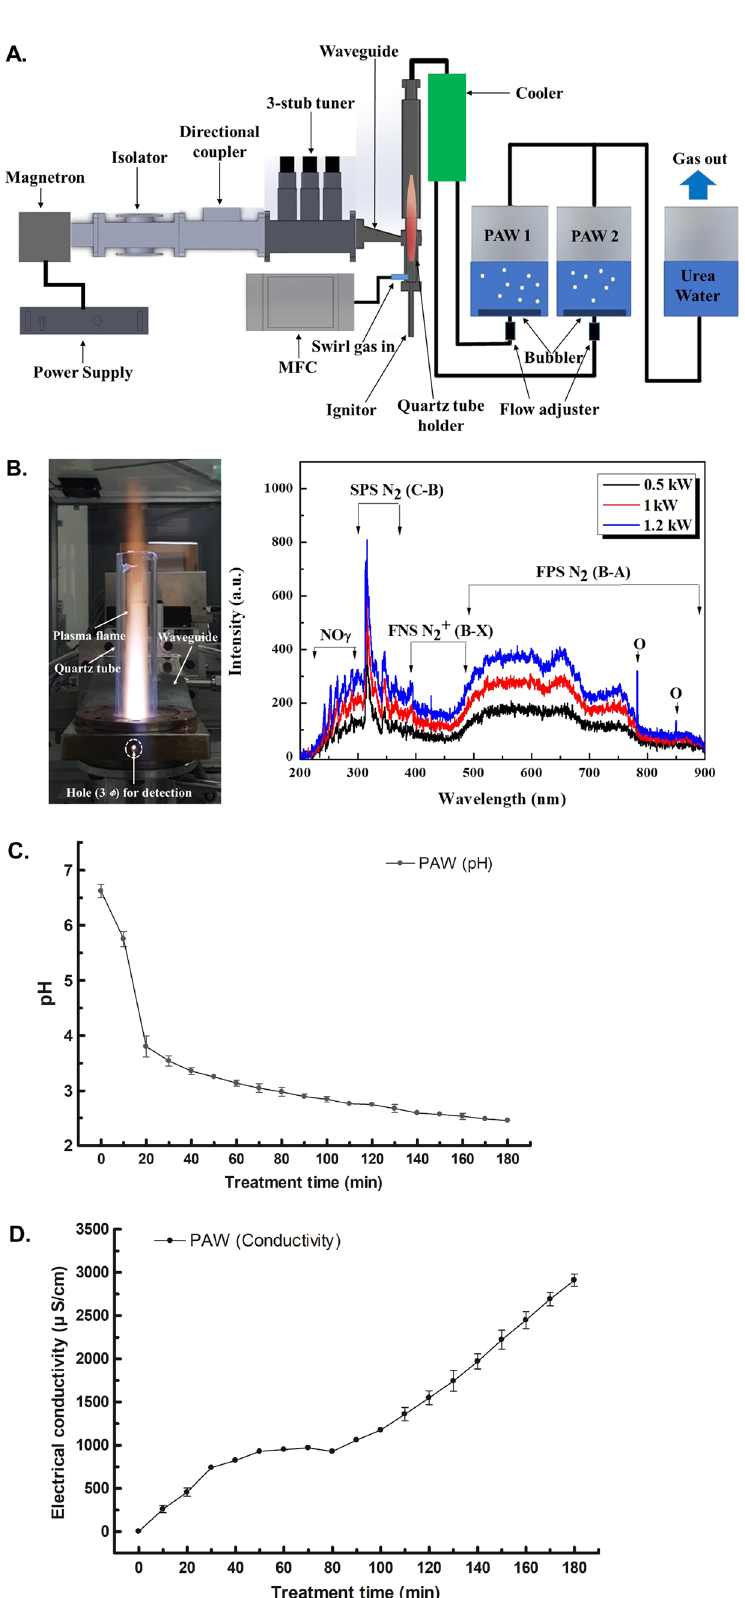
Figure 1. System for the generation of atmospheric microwave plasma-activated water (PAW) and real-time measurements of the pH and conductivity of PAW. ( A ) Schematics of the 2.45 GHz microwave plasma system and plasma-activated water system. ( B ) Optical emission spectra showing the chemical species produced from the plasma system operated at different powers. ( C ) The pH of PAW monitored for 3 h during microwave plasma treatment. ( D ) Plasma-activated water (PAW) conductivity increased gradually as the plasma treatment time increased. All data points represent means ± standard deviations of three replicate